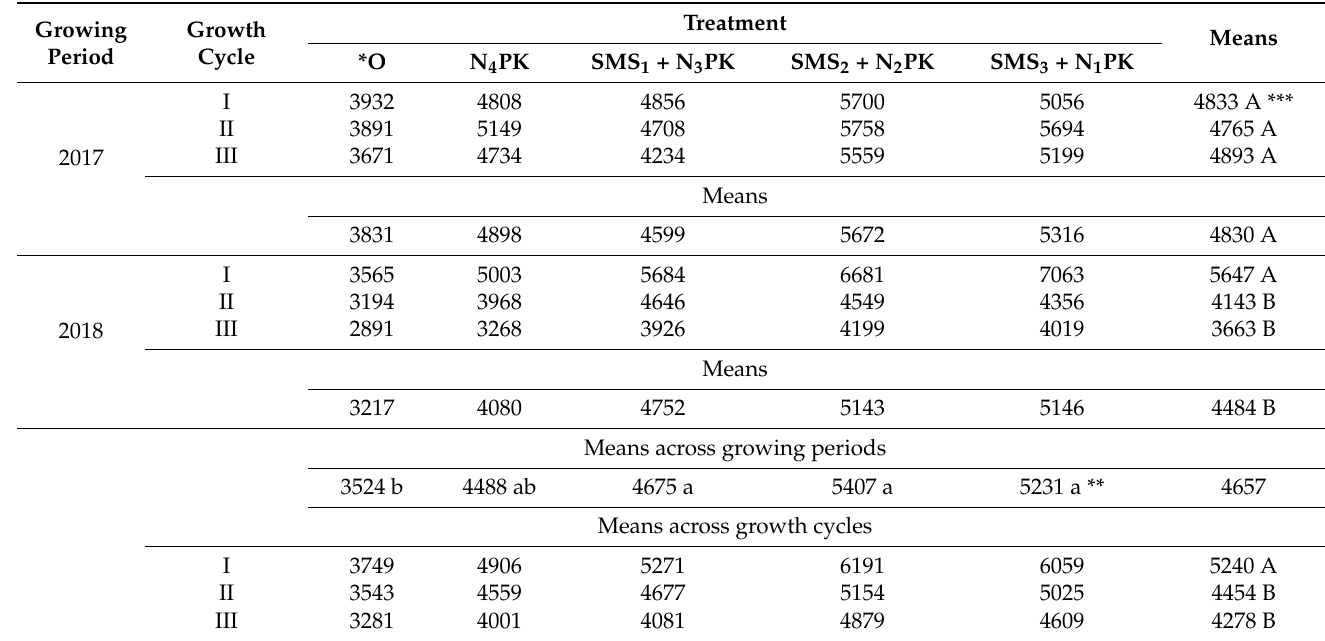
Table 8. The effect of fertilizer treatment, growing period and growth cycle on Festulolium braunii energy yield (JP · ha − 1